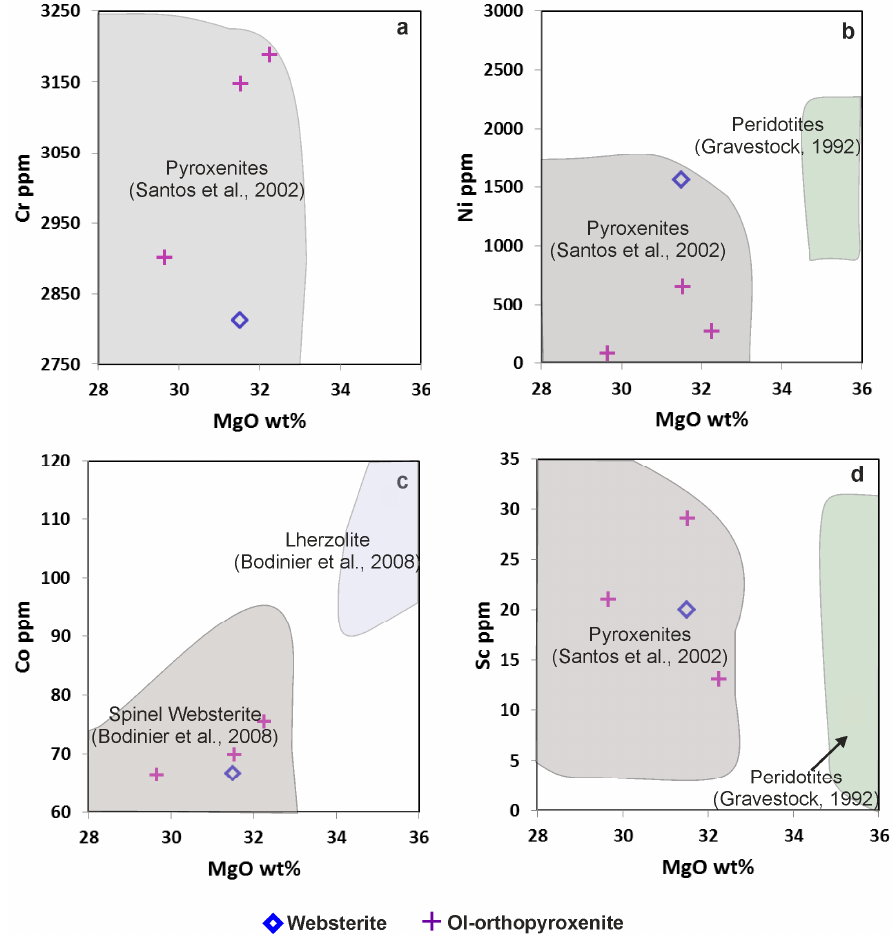
Figure 6. Variations of MgO versus: Cr ( a ); Ni ( b ); Co ( c ); and Sc ( d ), for the pyroxenites from the Veria-Naousa ophiolite (recalculated values to 100% on an anhydrous basis). Fields include data from Gravestock [44] and Santos et al. [45] for the Cabo Ortegal pyroxenites and peridotites, Bodinier et al. [11] for the Ronda spinel websterite and lherzolite.